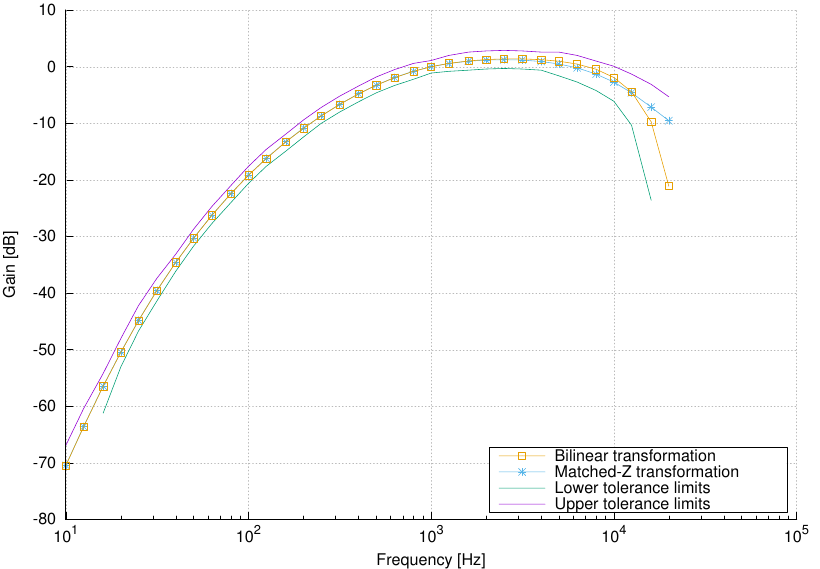
Figure 5. Magnitude responses of digital A-weighting filters designed using bilinear and matched-z transformations. Tolerance limits for filters in Class 1 sound level meters are shown.